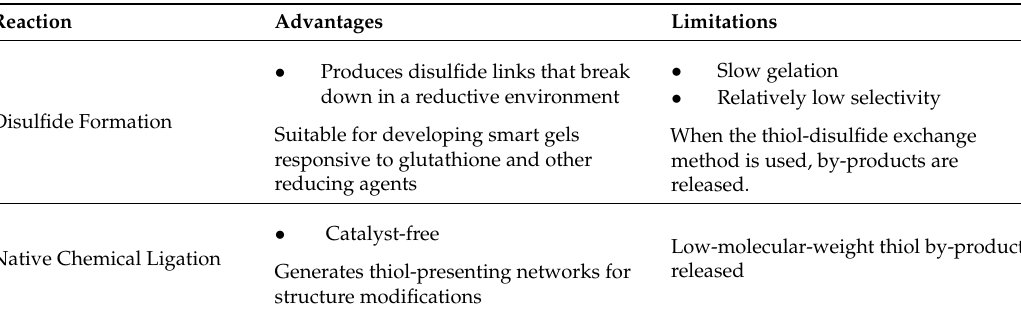
Table 1. Thiol-mediated reactions for hydrogel crosslinking in